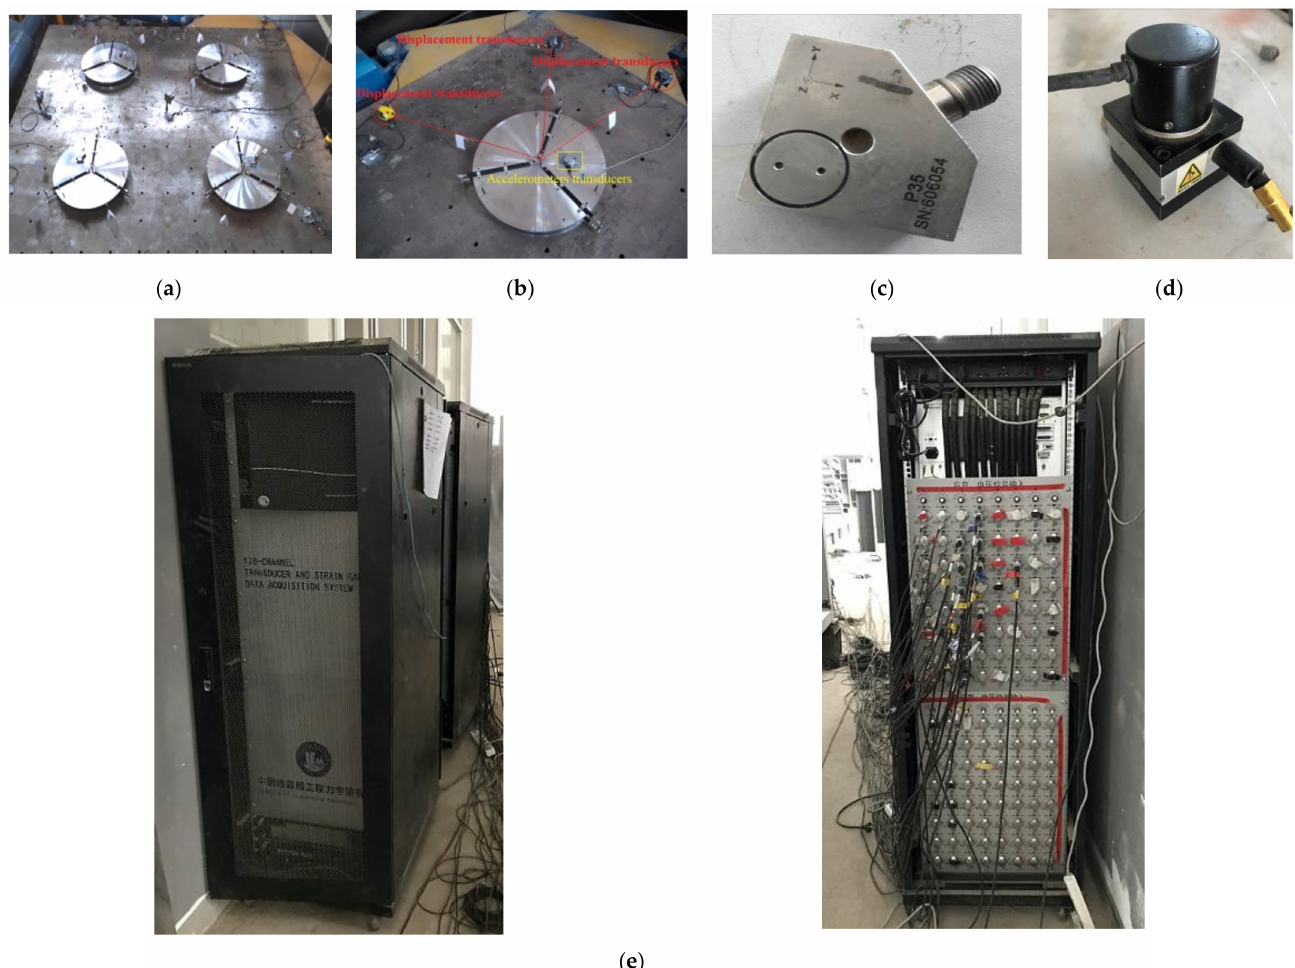
Figure 16. The overall layout of measuring points with ( a ) and the detail layout with ( b ); Acceleration sensors with ( c ) and drawing displacement sensors with ( d ); Pacific data collector with ( e